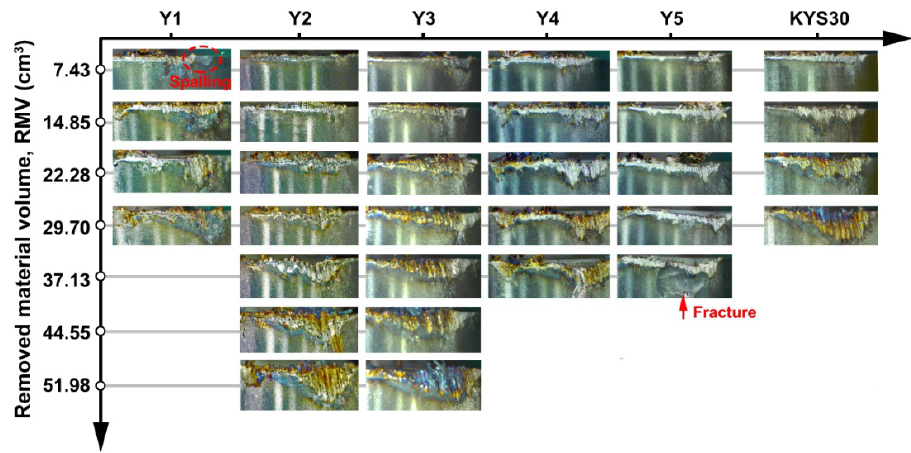
Fig. 12 Flank face morphologies of microwave-synthesized α / β -SiAlON samples (Y1–Y5) and commercial α / β -SiAlON insert (KYS30) under different RMVs.